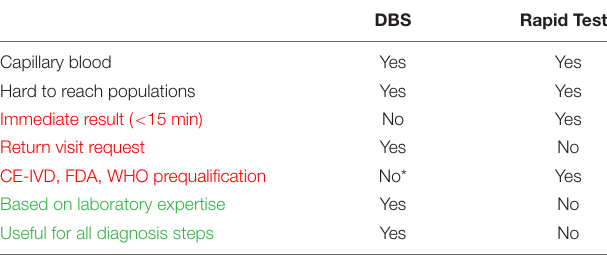
TABLE 1 | Comparison of the characteristics of DBS tests and rapid diagnostic